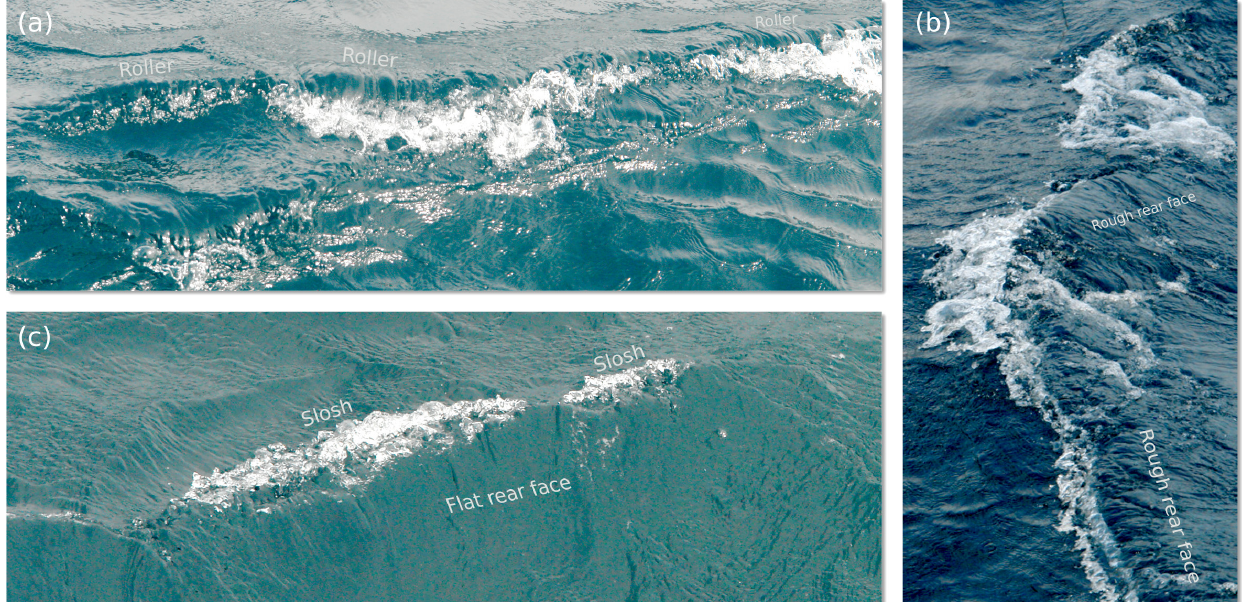
Figure 11. Photos illustrating a variety of deep-water breaking wave types observed at the Black Sea Research platform [73]: ( a ) up-wave view of a roller breaker, ( b ) cross-wave view of a breaker with a rough rear face, and ( c ) down-wave view of a slosh breaker with a smooth rear face. The breaking crest lengths are ∼ 1.5–3 m. The incidence angle is 50 ◦